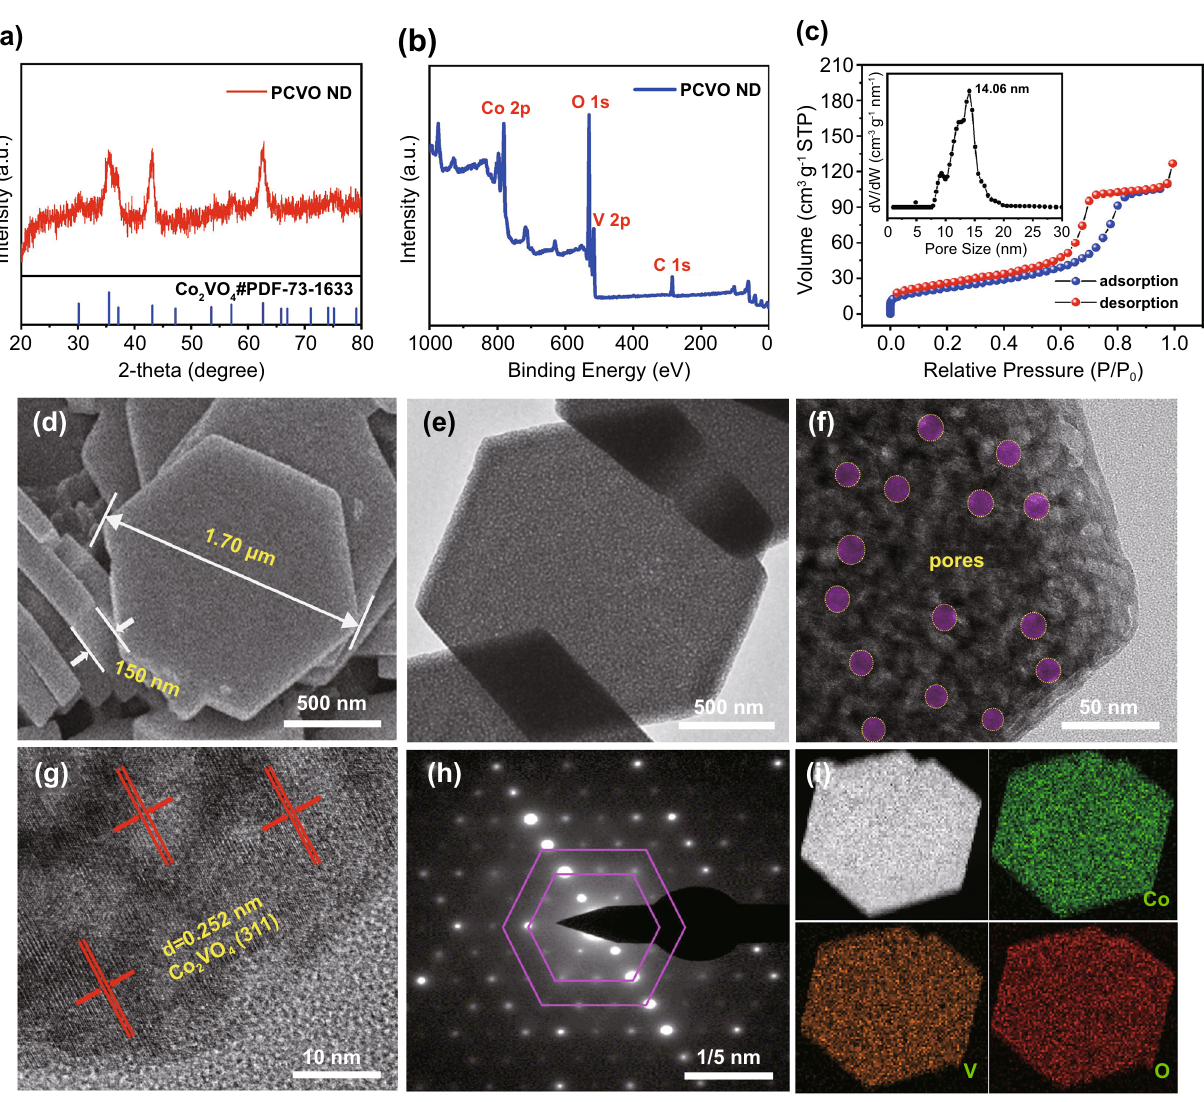
Fig. 3 a XRD pattern of PCVO ND. b XPS full survey spectrum of PCVO ND. c Nitrogen adsorption and desorption isotherms of PCVO ND (Inset is the corresponding pore size distributions). d FESEM image of PCVO ND. e and f TEM images. g HRTEM image. h SAED pattern. i STEM and the corresponding elemental mapping images indicating the homogeneous distribution of all three elements of Co, V and